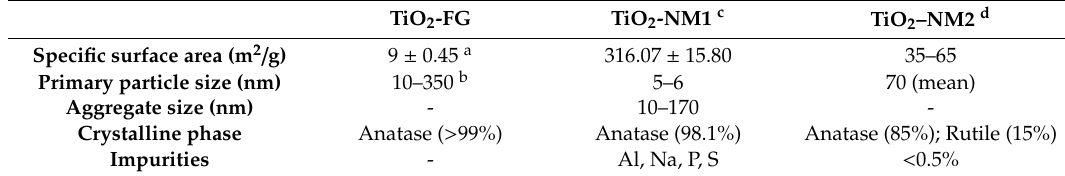
Table 1. Physical and chemical properties of the TiO 2 samples